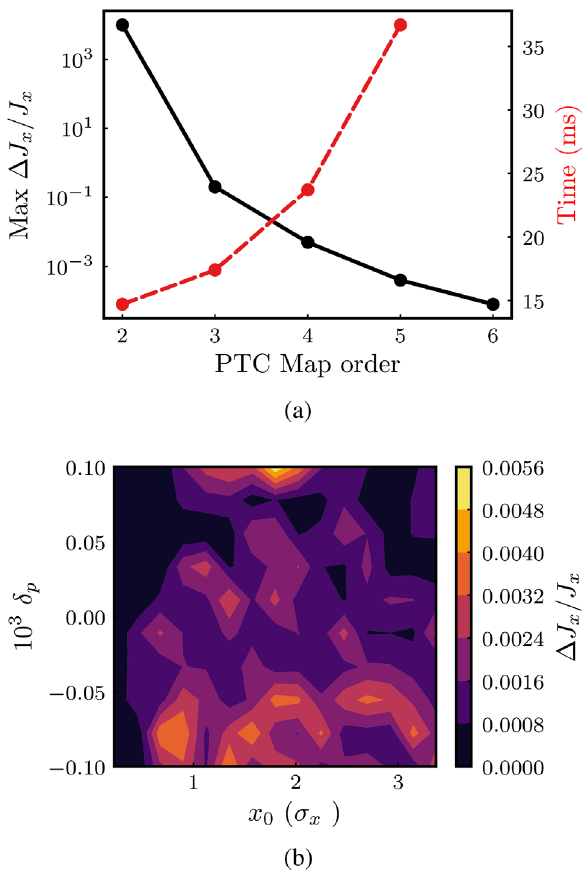
FIG. 9. Comparison of tracking using sector maps extracted at different order from PTC and element-by-element tracking with MAD-X PTC at 20th-order, using 150 particles tracked for 300 SPS turns. (a) Maximum error on the horizontal action (black) and time needed for tracking (red) as a function of the map order. (b) Maximum error on the action using 4th-order sector maps with different initial conditions.